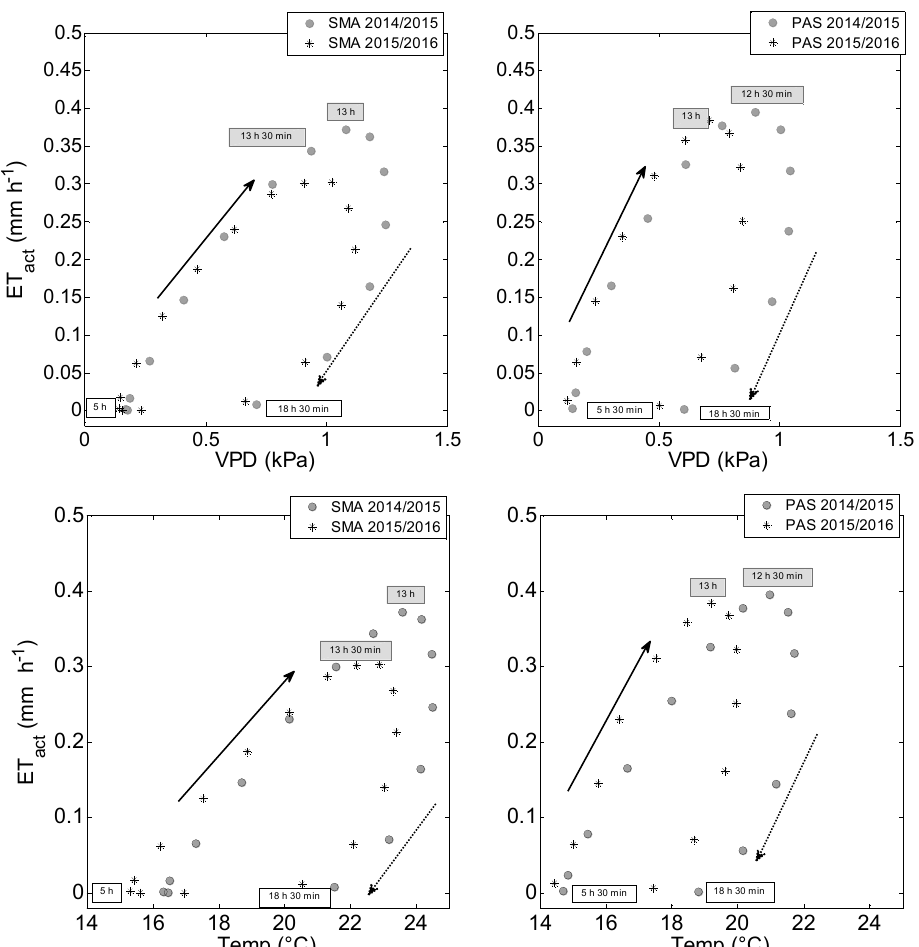
Figure 9. Hysteretic loops relating actual ET act and VPD ( top panels ) and air temperature ( bottom panels ) for SMA ( left panels ) and PAS ( right panels ) for different years. The arrows indicate the direction of the hysteresis effect—morning with a solid arrow and afternoon with a dashed arrow. Gray rectangles indicate the timing (hour) when maximum ET occurs. White rectangles indicate the inversion timing (hour) of the ET signal.